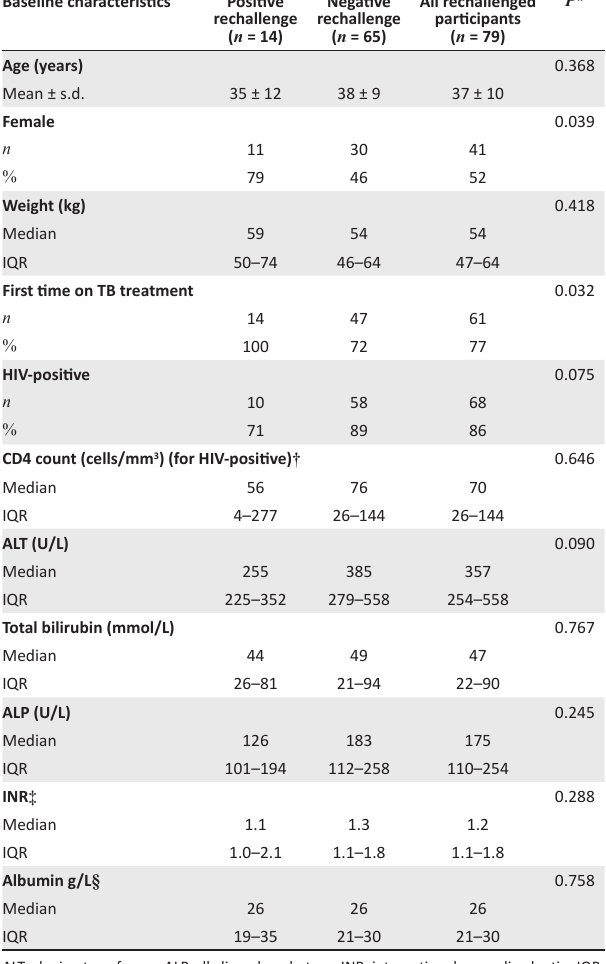
TABLE 1: Baseline characteristics of participants with positive and negative rechallenge following anti-tuberculosis drug-induced liver injury. Baseline characteristics